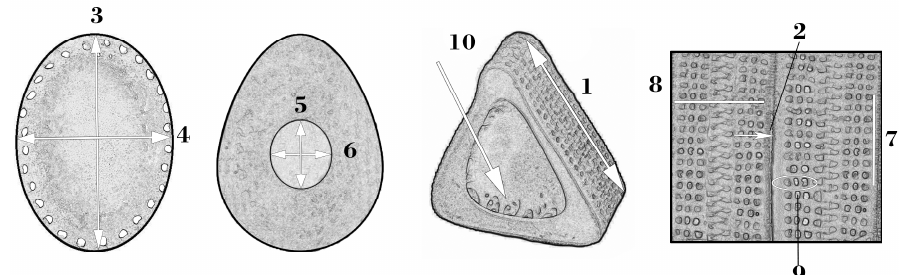
Figure 3. Morphometric features of Alveolophora antiqua : 1—length of side face; 2—valve height; 3— valve diameter by apical axis ( а . а ); 4—valve diameter by transapical axis (t.a); 5—diameter of the ringleist aperture by apical axis; 6—diameter of the ringleist aperture by transapical axis; 7— number of areolae rows in 10 µ m; 8—areolae number in 10 µ m of a row; 9—areolae number in a row; 10—costae number in 10 µ m.